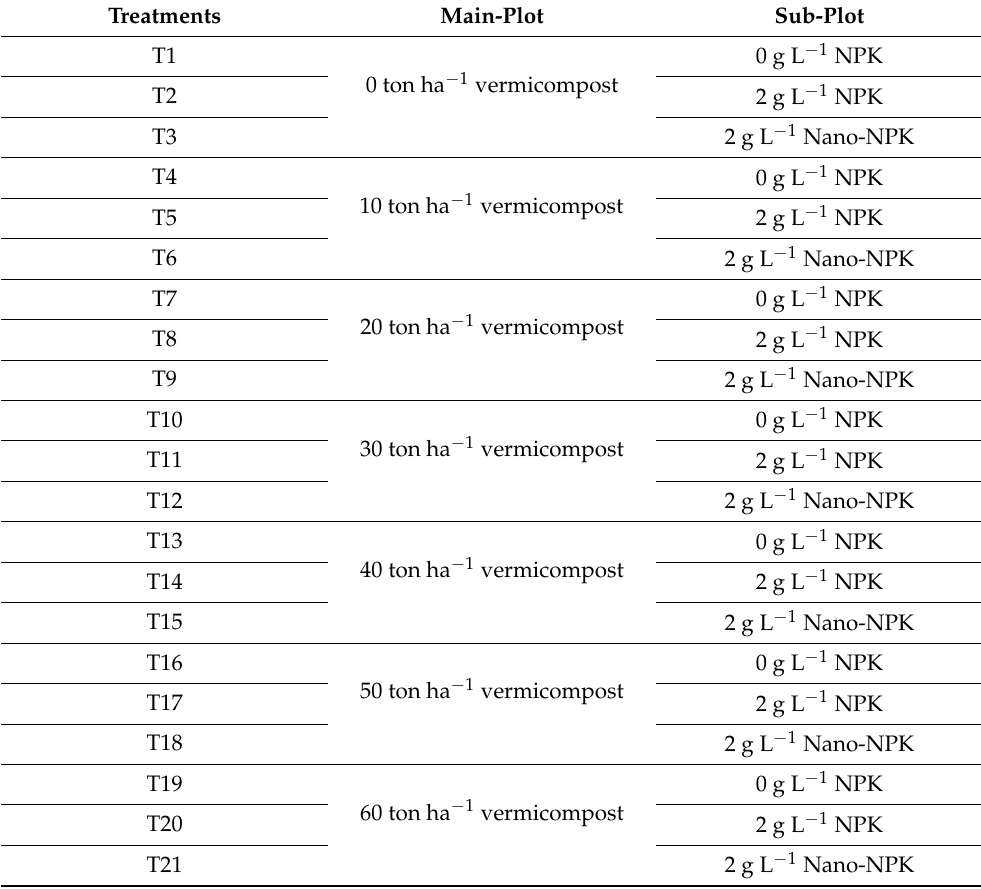
Table 10. All different combination treatments of vermicompost and NPK fertilization used. Treatments Main-Plot